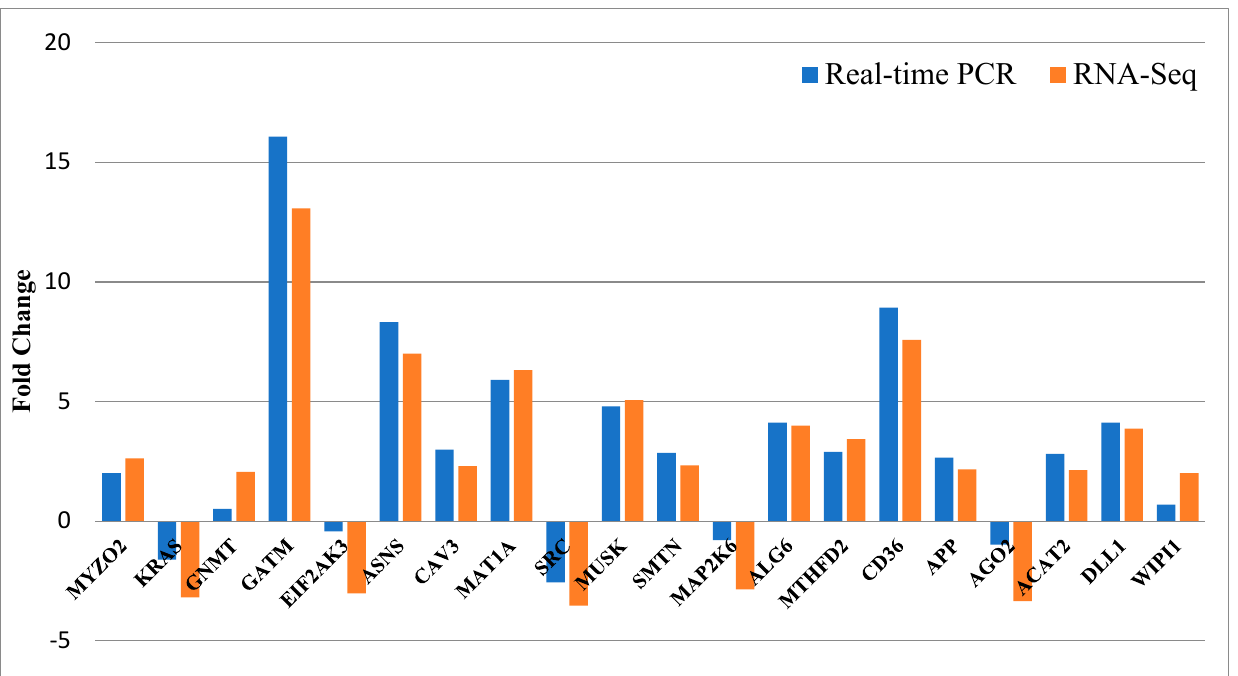
Figure 8. Expression stability analysis of reference genes in breast muscle tissue of turkeys. The most stably expressed genes have lower M values.